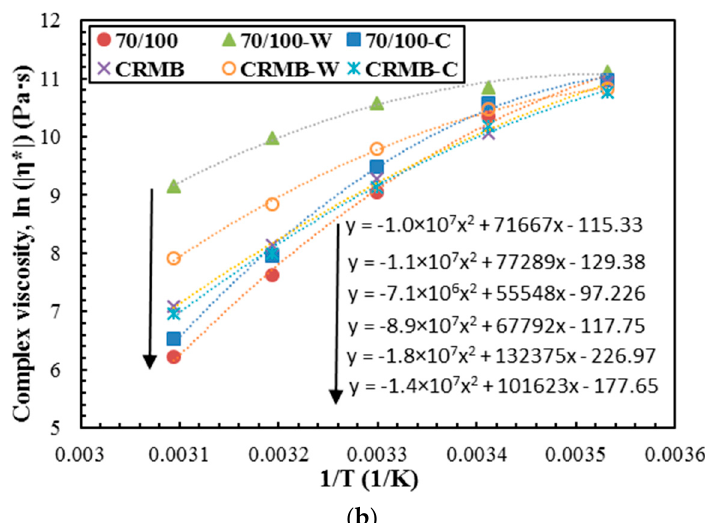
Figure 7. Logarithmic complex viscosity as a function of the reciprocal of temperature ( a ) at shear rate of 0.01 rad/s; ( b ) at shear rate of 100 rad/s.